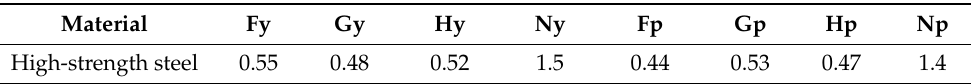
Table 6. Summary of the anisotropic coefficients of low-carbon steel. Material Fy Gy Hy Ny Fp Np Low-carbon steel Table 7. Summary of the anisotropic coefficients of high-strength steel. Material High-strength